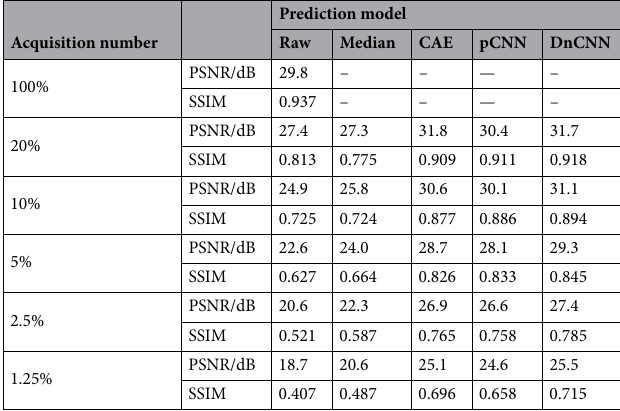
Table 1. PSNR and SSIM for the raw and predicted NR